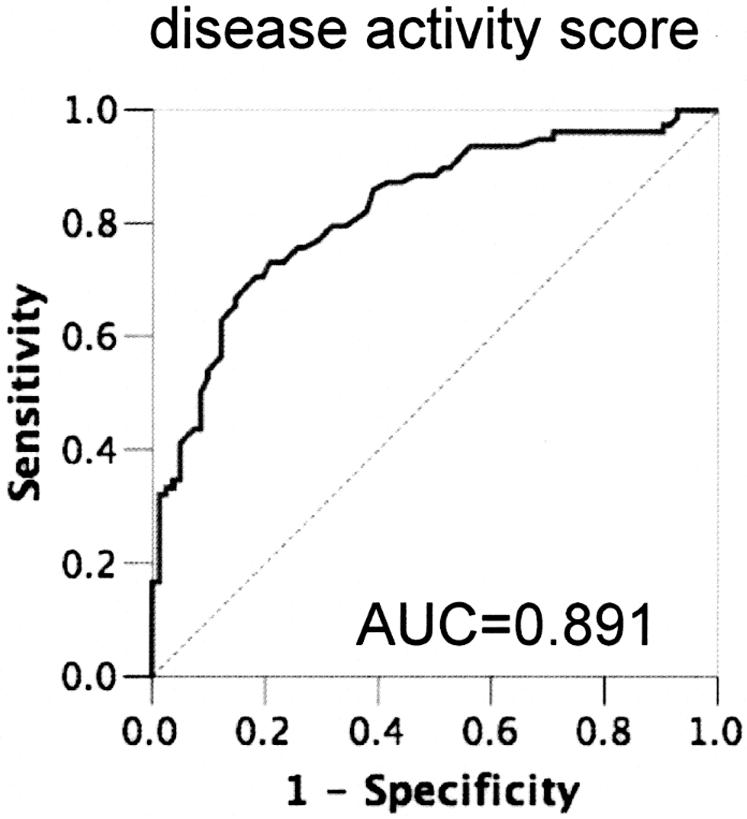
Diagnostic accuracy of the disease activity score.Sensitivity and specificity of the disease activity score to distinguish between asymptomatic and symptomatic patients is shown as receiver operating curve. Area under the curve is 0.891. The AUC for the null hypothesis is 0.5.